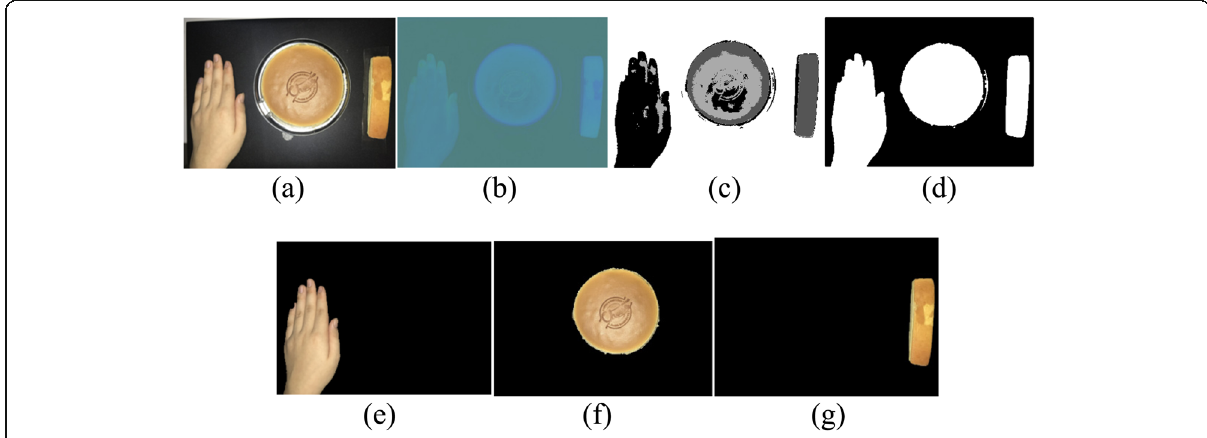
Fig. 8 Effects of map. a Original picture. b Picture in LAB color space. c Effects of segmentation. d After morphological processing. e Segmentation result-hand. f Segmentation result-cake. g Segmentation result-cheesecake